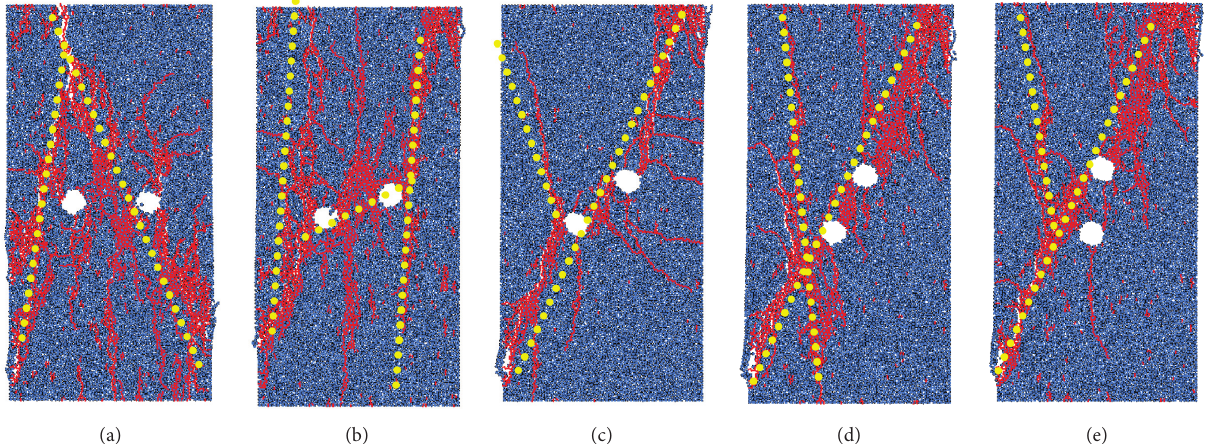
Figure 22: Failure modes of samples with different boreholes dip angle. The α of (a), (b), (c), (d), and (e) are 0 ° , 20 ° , 40 ° , 60 ° , and 80 ° ,